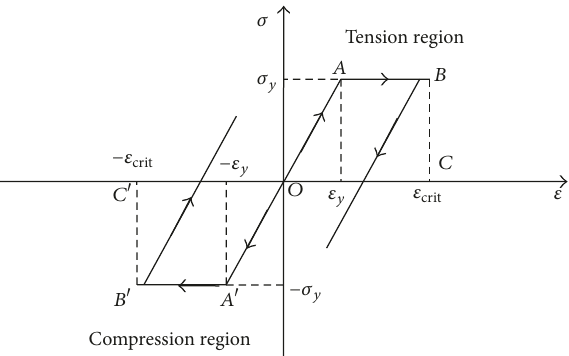
Figure 7: Ideal elastic-plastic stress-strain curve of steel.